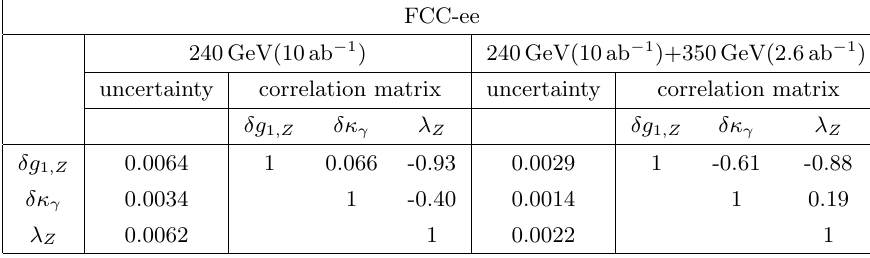
Table 6 . Same as table 5 but for